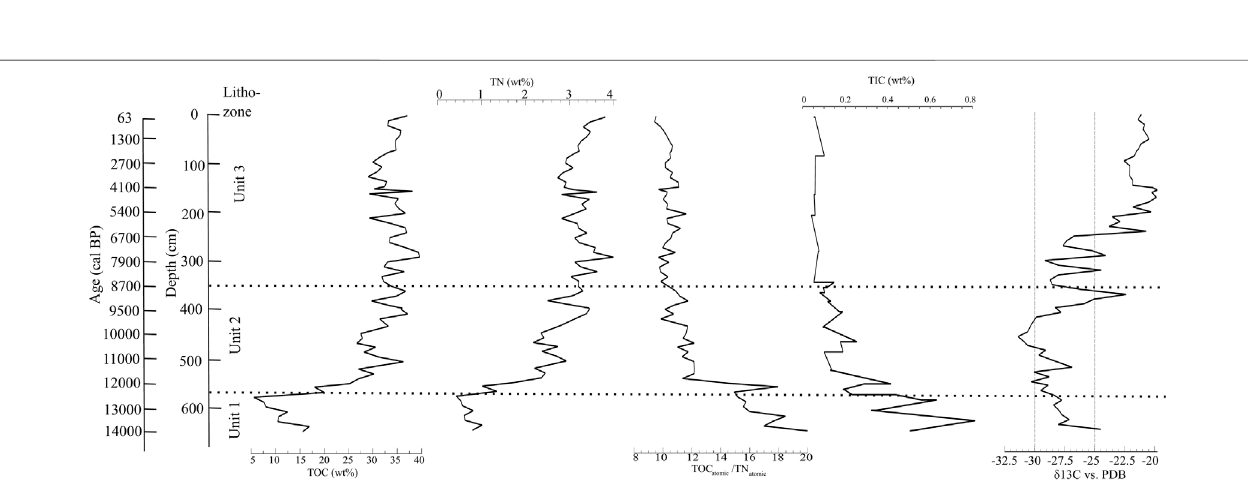
FIGURE4| Biogeochemical proxies measured of78 discrete samples, including total organic carbon (TOC), total nitrogen (TN), TOC/TN atomic ratio,total inorganic carbon (TIC) and δ 13 C trends (vertical dashed lines represent the usual isotopic signature of C3 land plants; see Figure 7 ).